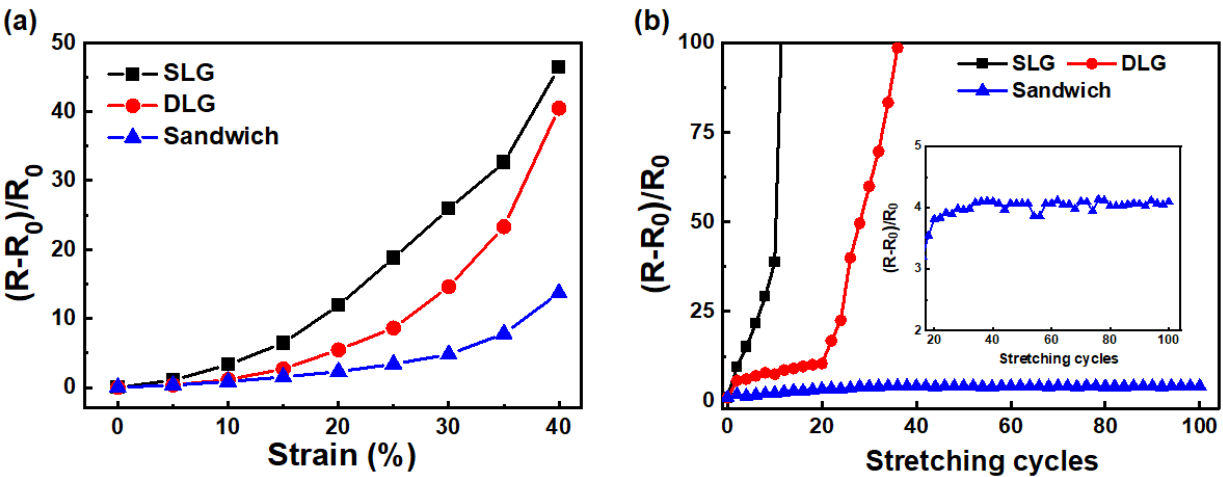
Figure 5. ( a ) Variation of electrical resistance with tensile strain. ( b ) Stretching stability under 20% strain for SLG, DLG and the sandwich structure.